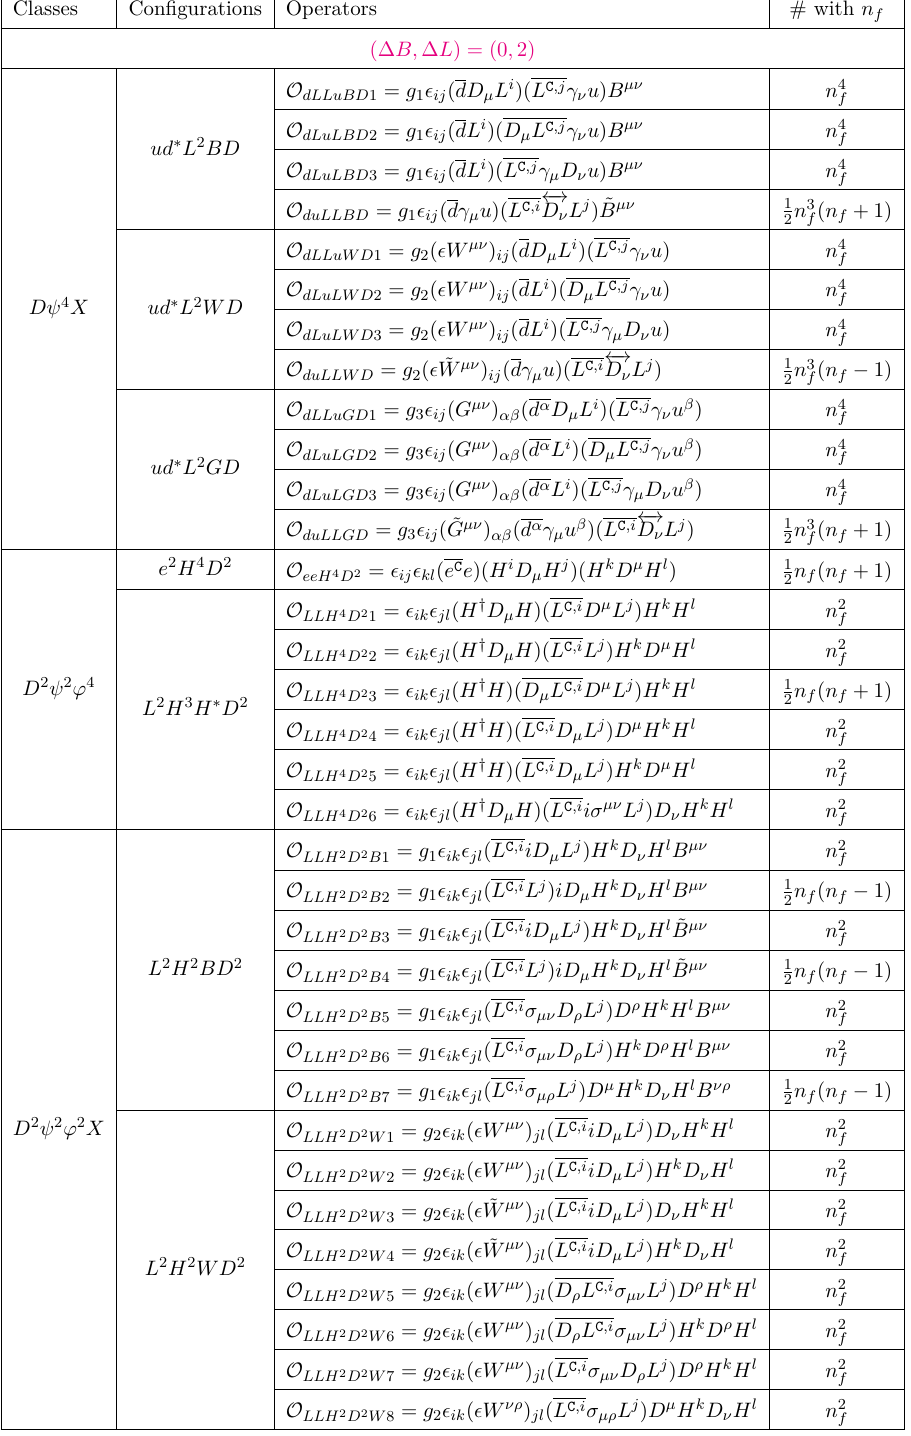
Table 5 . Dim-9 operators in classes Dψ 4 X, D 2 ψ 2 ϕ 4 , D 2 ψ 2 ϕ 2 X for sector (∆ B, ∆ L ) = (0 , 2) . There are 34 operators without counting fermion generations and 30 remain for one generation case. Hermitian conjugated operators are not included or